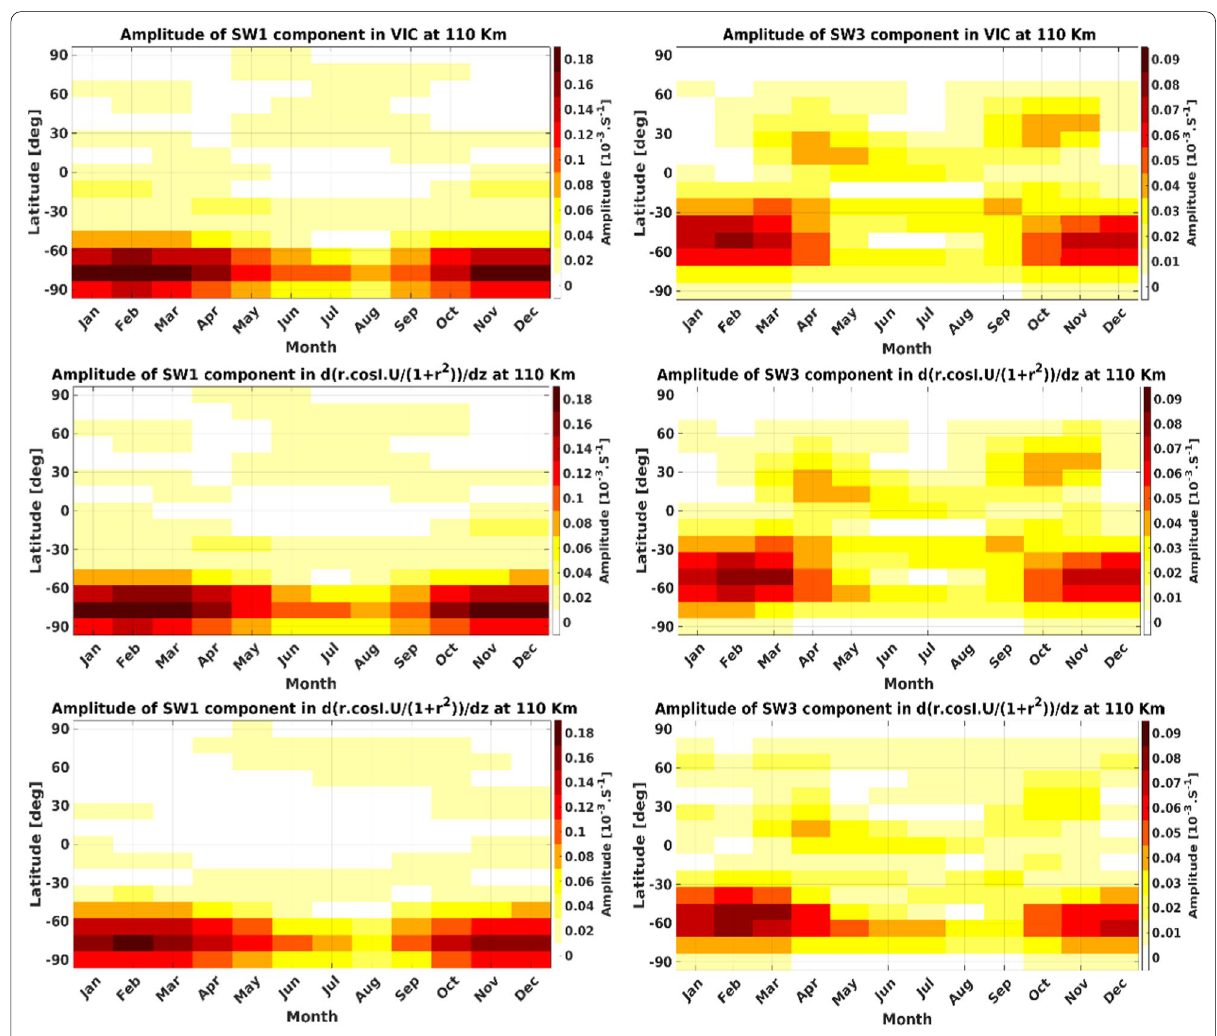
Fig. 8 Month‑to‑month amplitude variation of SW1 (left column) and SW3 (right column) components of VIC (first row), zonal wind term in VIC (second row) and the zonal wind term VIC without the effect of magnetic field zonal asymmetry (third row) at different